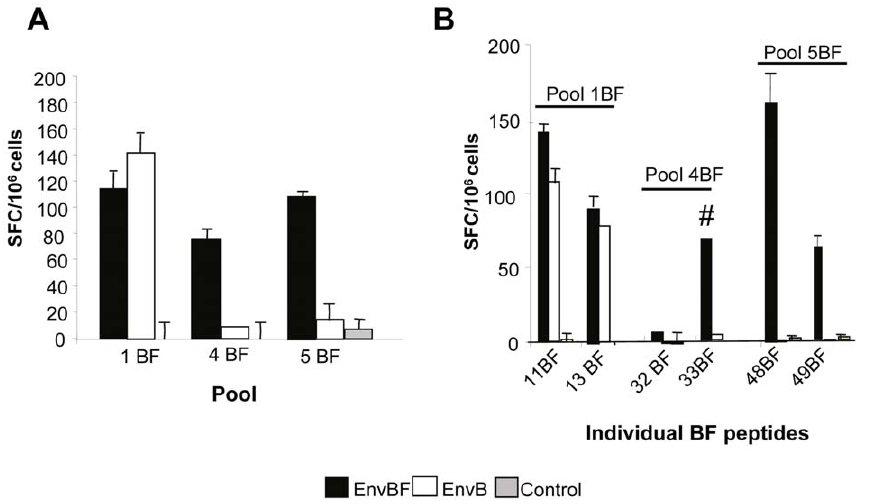
Figure 4. Reactivity against subtype BF peptides. A ) Cellular immune responses against the EnvBF regions indicated (pools 1, 4 and 5). B ) After performing a matrix-peptide based analysis as it is depicted in Fig. 3A, the identified BF peptides were evaluated individually. Data are representative of two independent experiments. Symbol: # denotes that the response shown was obtained in 50% of the experiments.